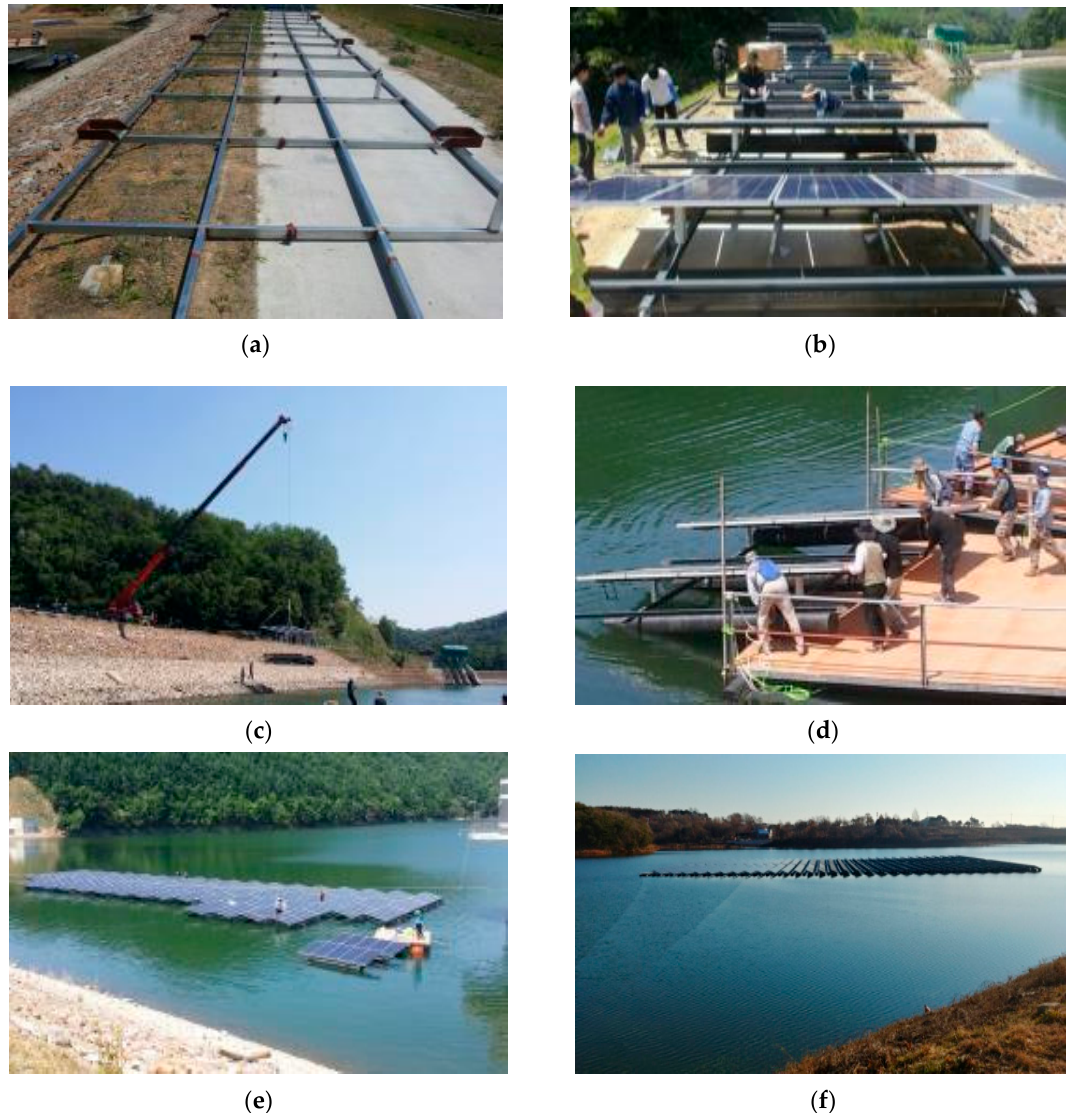
Figure 15. Construction procedure of the floating photovoltaic power generation structure. ( a ) Basic